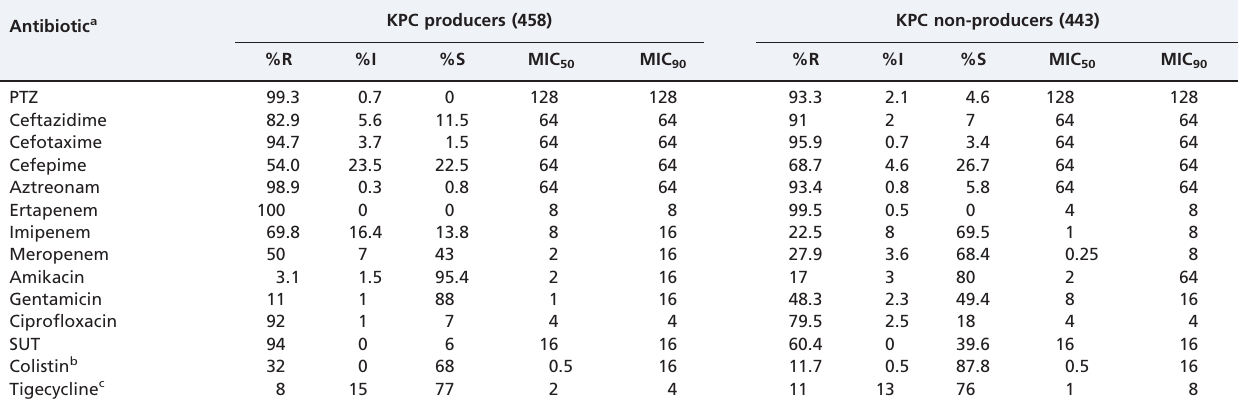
Table 3 - In vitro activity of antimicrobial agents tested against 901 ENSE isolates. Antibiotic